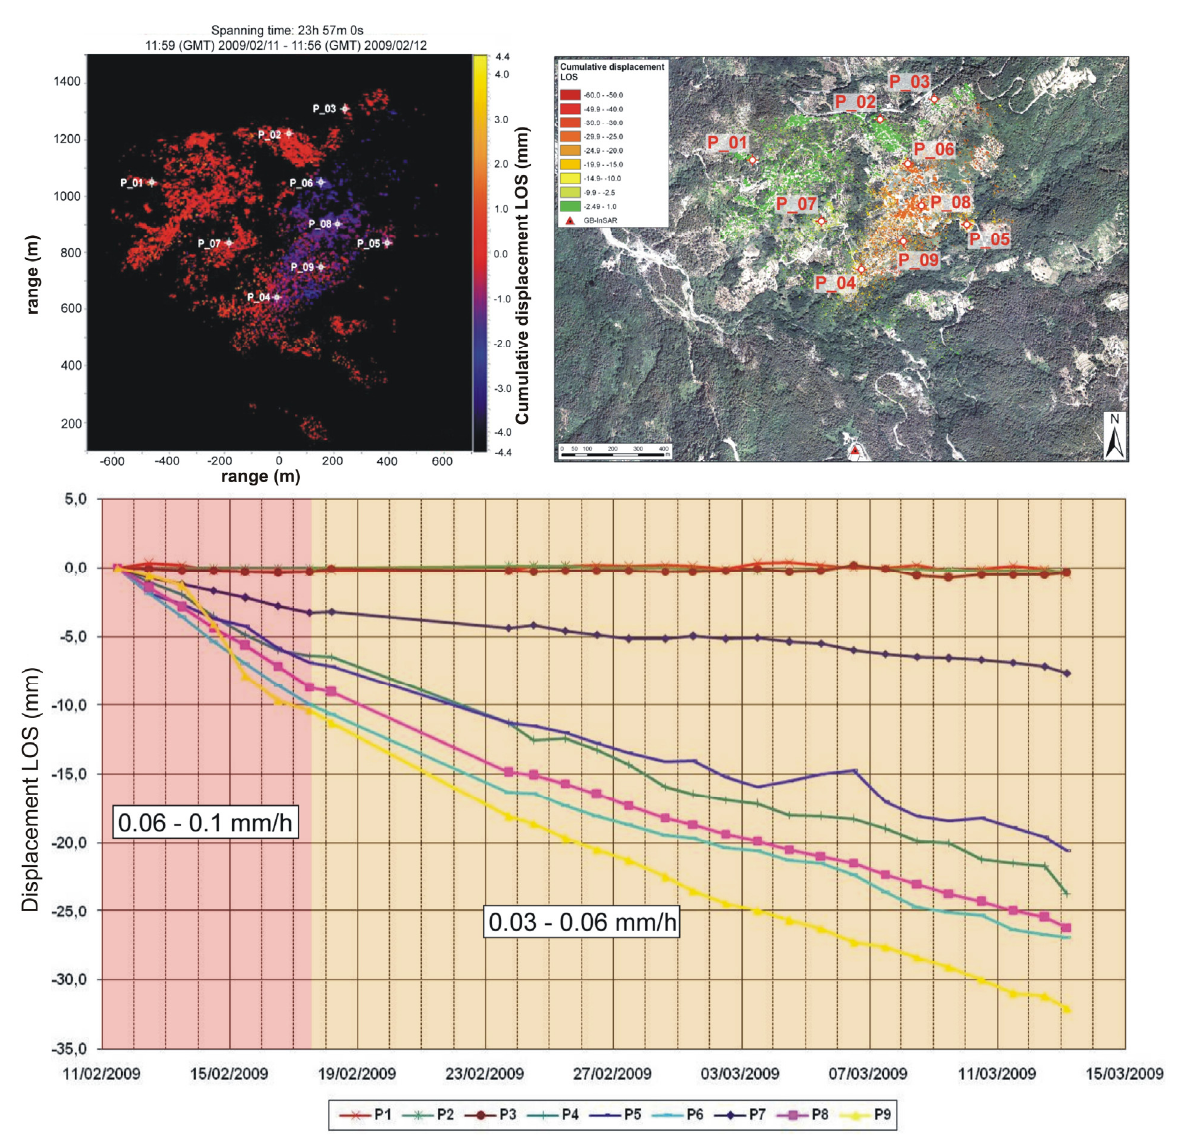
Figure 9. Time series analysis of nine points of the monitored area. The location of the points is shown both on the interferogram ( upper left corner ) and on the landslide map ( upper right corner